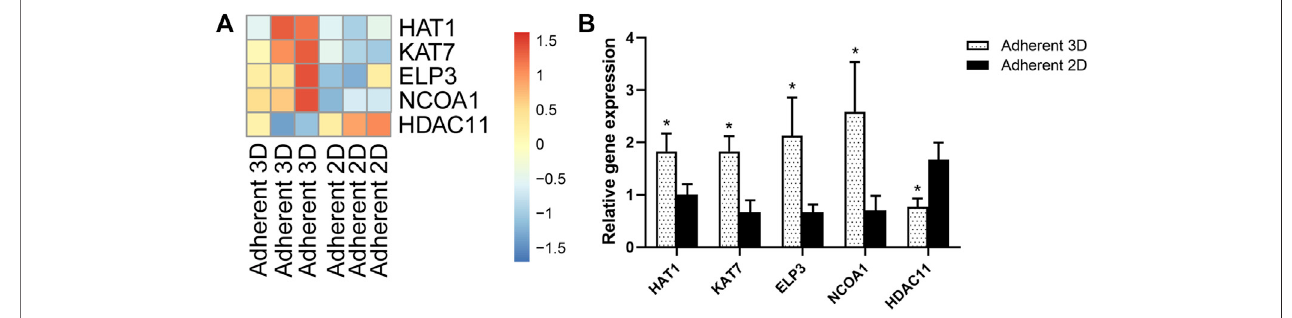
FIGURE 7 | Mechanotransduction increased expression of histone acetyltransferase genes and reduced expression of histone deacetylase genes. (A) The heat map shows the DEGs of histone acetyltransferase and histone deacetylase. (B) Mechanotransduction acts on histone, which was validated by qPCR. (* p < 0.05).